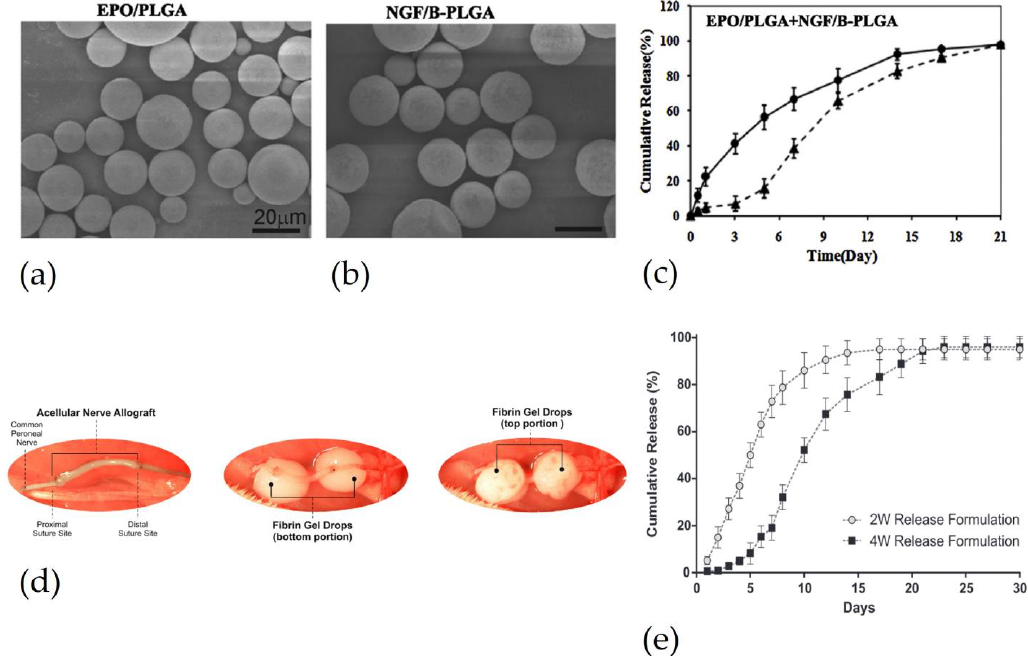
Figure 4. DDS directly injected in the damaged nerve: ( a ) PLGA MSs loaded with erythropoietin. ( b ) BSA-incorporated PLGA MSs loaded NGF ( c ) EPO release from PLGA MSs and NGF release from BSA-PLGA MSs. Reproduced and adapted with permission from [60], Copyright © 2017 Published by Elsevier B.V. ( d ) Procedure to inject fibrin gel, as a drug delivery system. The first image shows a cellular nerve allograft used to bridge a 5 mm nerve gap. The second and third images show the injection of fibrin gel in the top and bottom portions, respectively, of the proximal and distal stumps. ( e ) Comparison of GDNF release between PLGA MPs with different molecular weights: light dot indicates PLGA microparticles with lower molecular weight and dark square PLGA mi- croparticles with high molecular weight. Reproduced and adapted with permission from [63], Cop- yright © 2015 Acta Materialia Inc. Published by Elsevier.